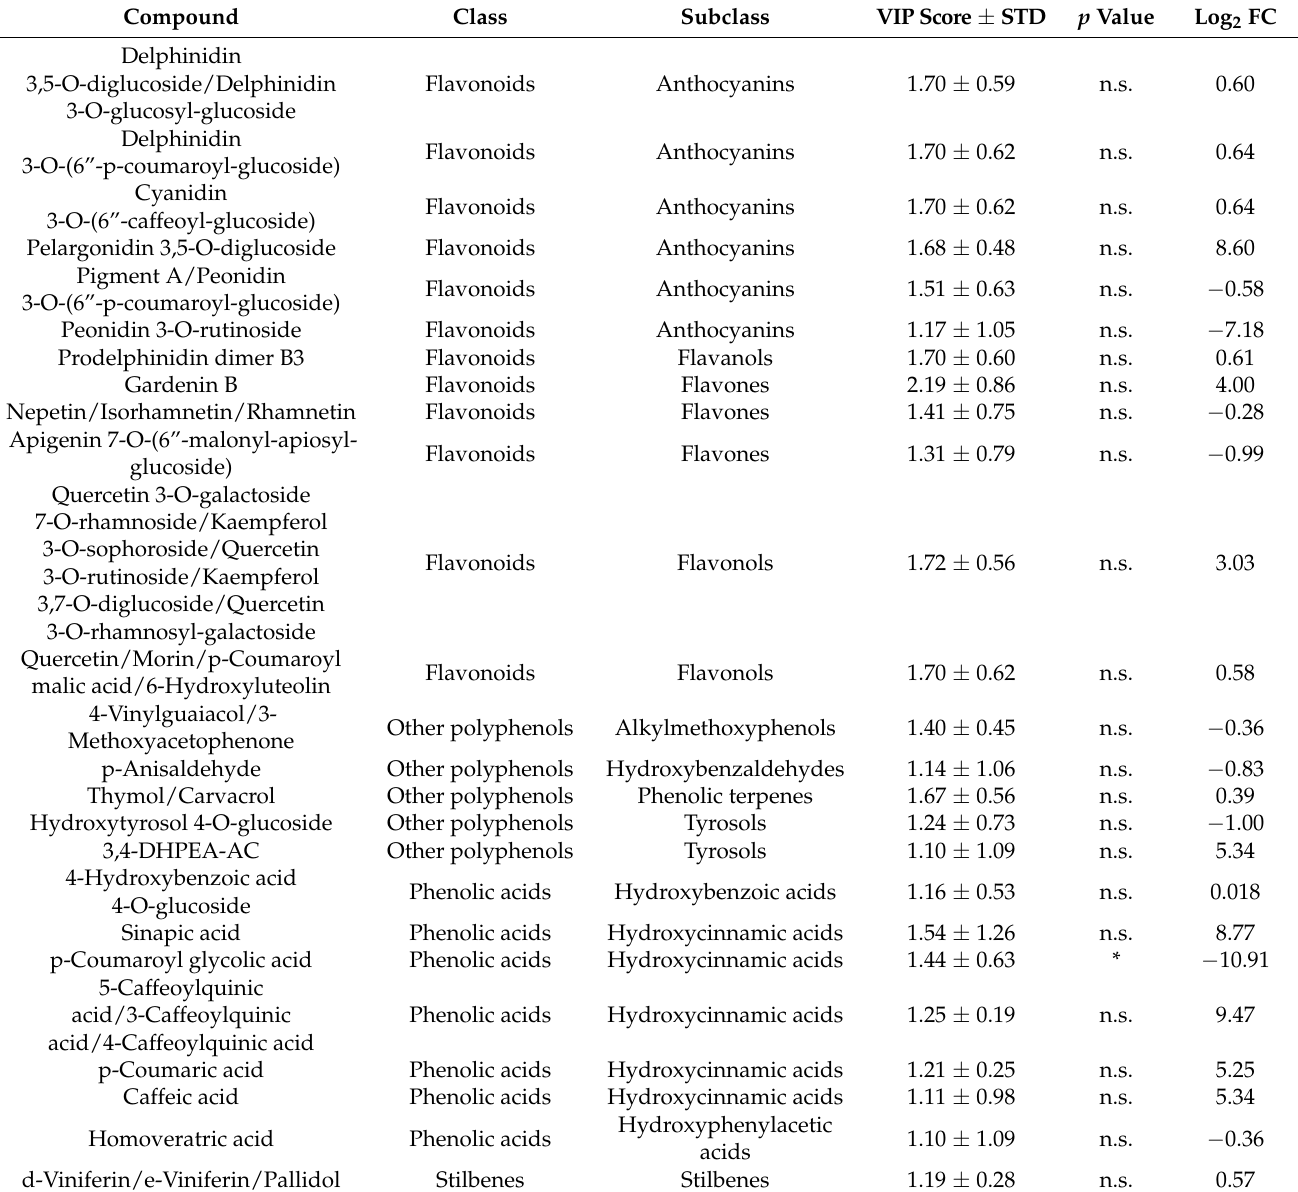
Table 4. Discriminant phenolic compounds identified in roots according to VIP associated with the OPLS-DA model reported in Figure 4c (effect of UV treatment). Phenolic compounds, classified according to their class and subclass, are provided with p value and their Log 2 FC calculated in respect to control samples. * p ≤ 0.05, n.s., not